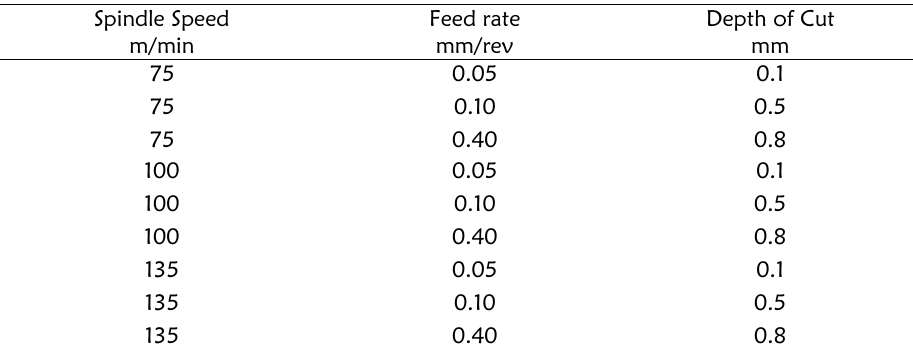
Table 3: Orthogonal Array for machining from